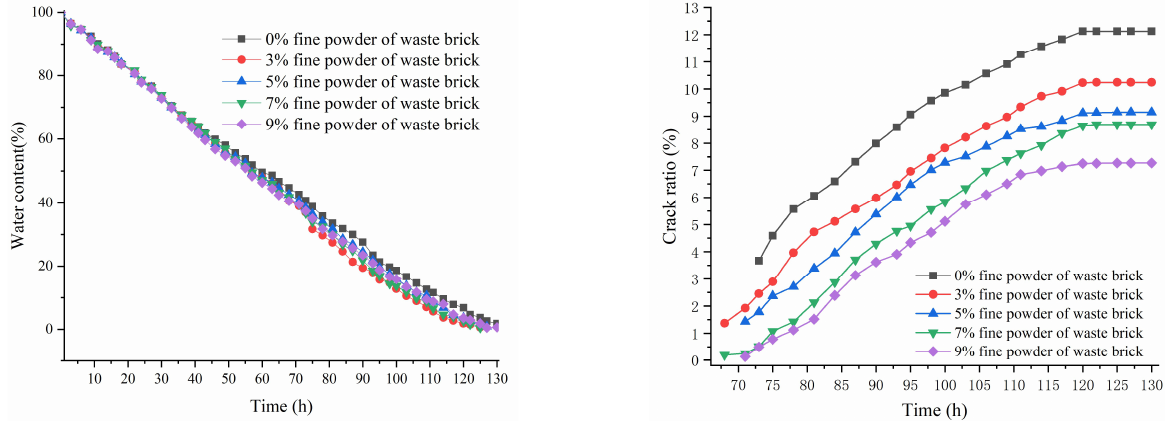
Figure 7. Image of water contents and crack ratios changing over time.